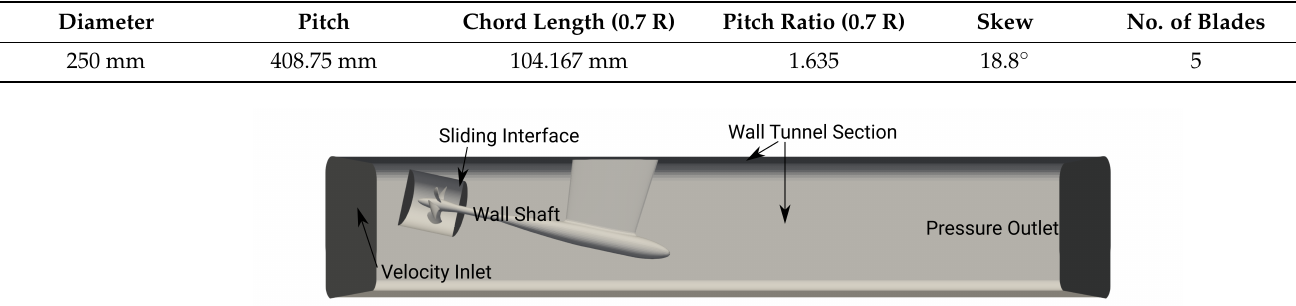
Figure 2. Simulation domain and boundary conditions.